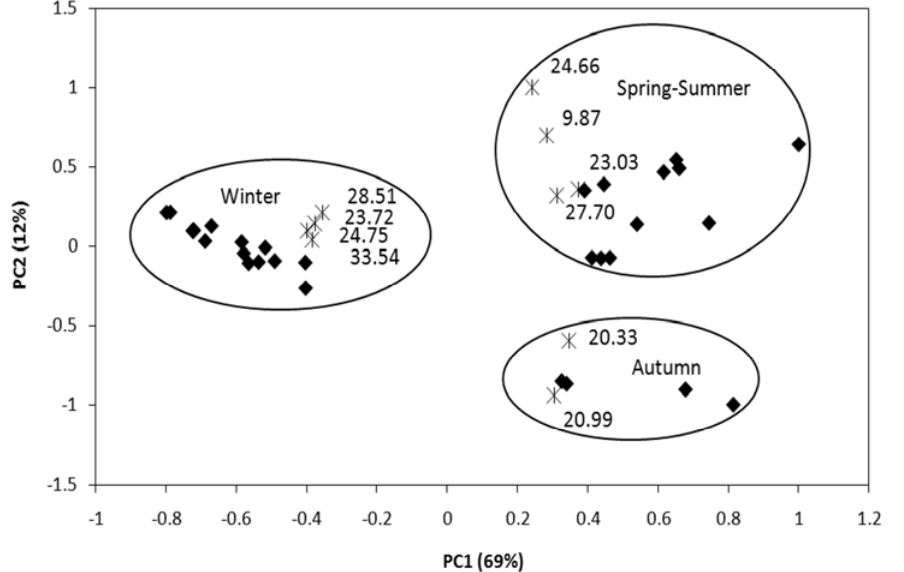
Figure 4. Biplot of PCA scores and loadings for the GC-FID volatile profile of the essential oil from leaves of Tetradenia riparia (Hochst.) samples ( ♦ ), using 10 selected variables ( (cid:188)